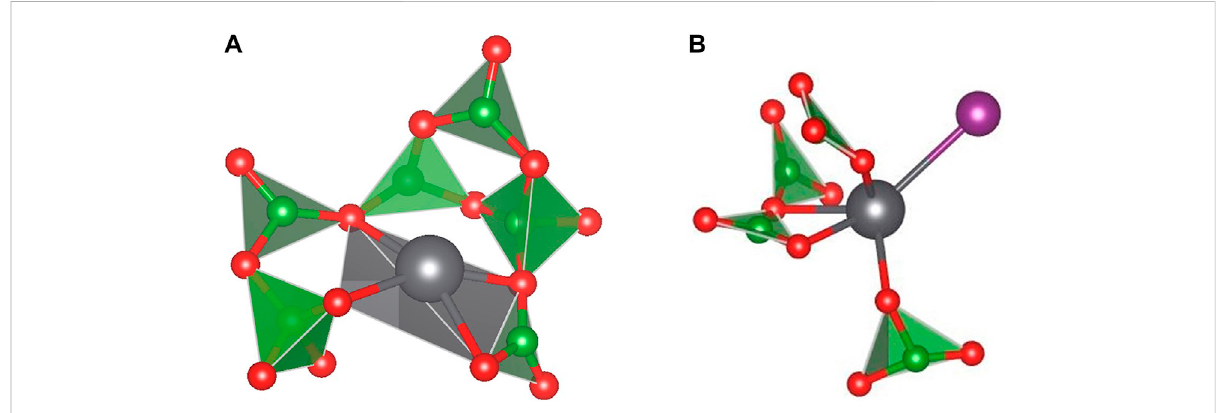
FIGURE 3 Typical structure of lead borate glass, showing Pb coordination (A) and Pb-I binding (B) . Grey: lead; Green: boron; Red: oxygen; Purple: Iodine (Mukunoki et al.,